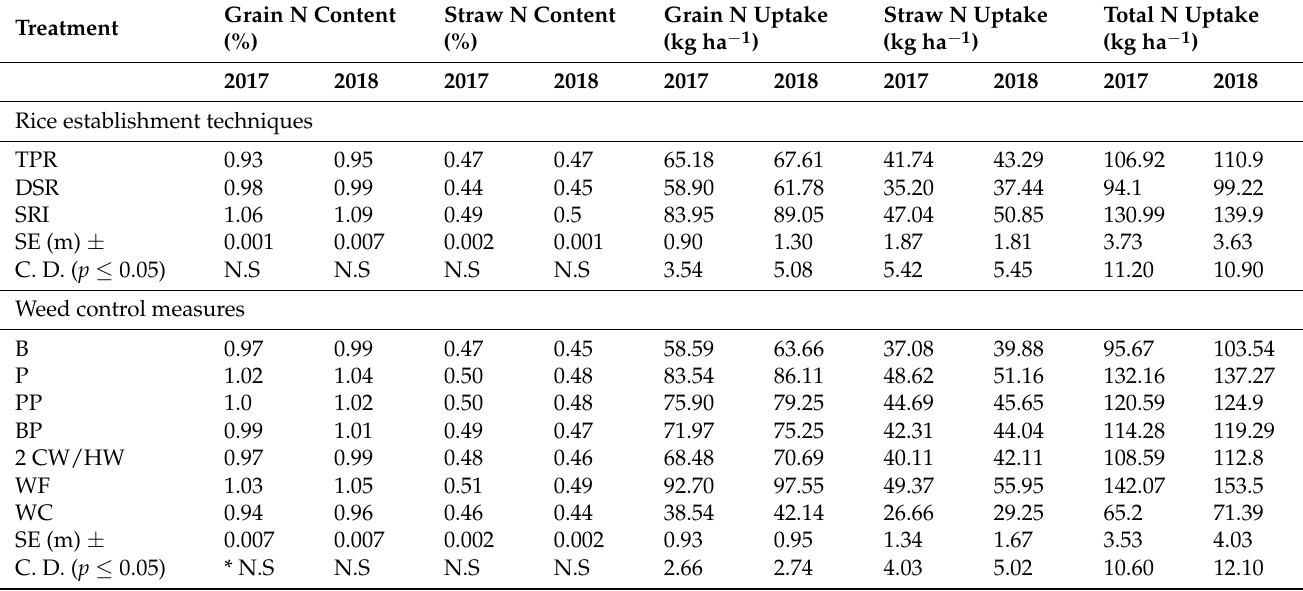
Table 4. Influence of rice establishment techniques and weed control measures on nitrogen content (%) and uptake (kg ha − 1 ) of rice.